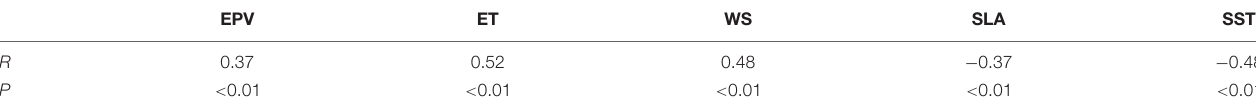
FIGURE 9 | Comparison of chlorophyll concentration at each station derived from satellites (i.e., surface layer) and in situ observation (i.e., 5 m-layer). The surface-layer Chl- a is produced through averaging Chl- a values for 2 pixels by 2 pixels near the in-situ stations, based the Chl- a data averaged for daily GlobColour data of 27–30 January 2010. TABLE 2 | The simple correlation coefficients between Chl- a blooms and ocean